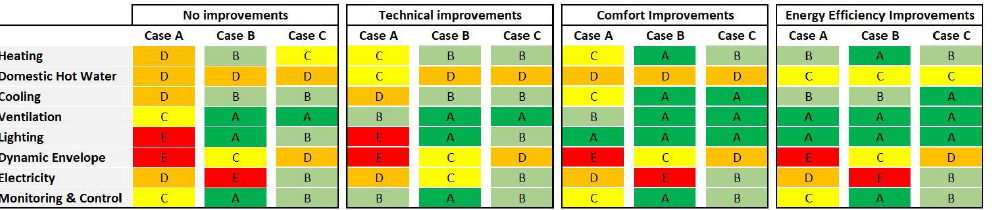
Figure 13. Comparison of the class scores for the different domains in the three buildings in the base case and the three improvements scenarios considered.